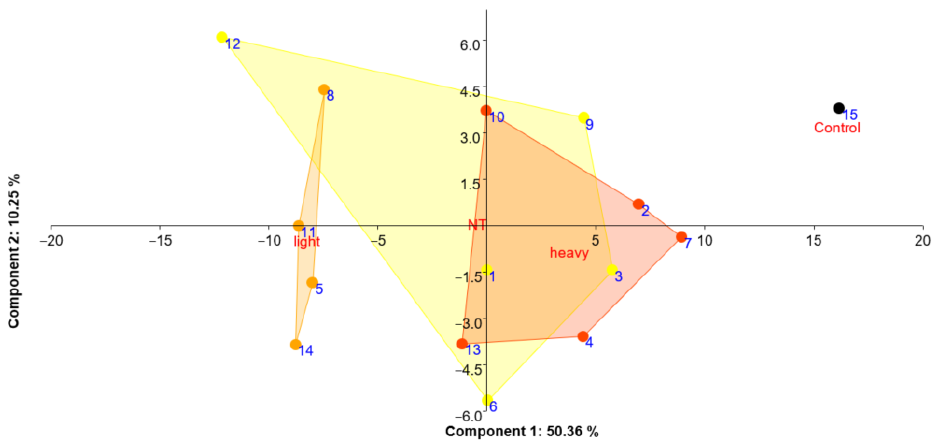
Figure 4. PCA score plot for spirits aged with different alternative products. Results of NMR analyses. The graph highlights the effect of toasting on spirit composition. Yellow, NT, non-toasted wood; red, heavy toasting; orange, light toasting.